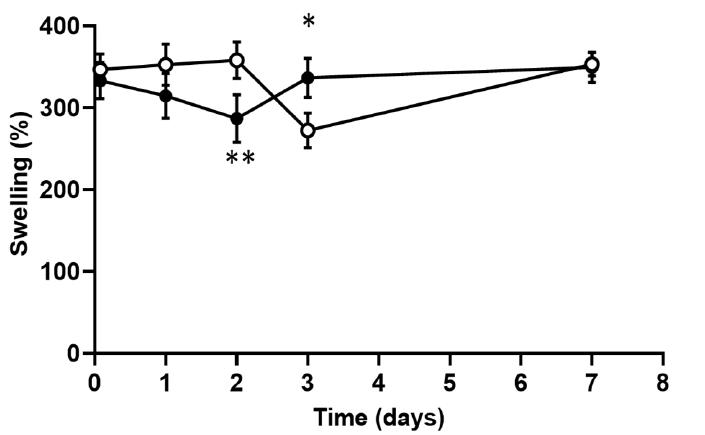
Figure 4. Swelling profile of the chitosan scaffolds (white dots) and curdlan–chitosan scaffolds (black dots) over time (* p < 0.05 et ** p < 0.01).